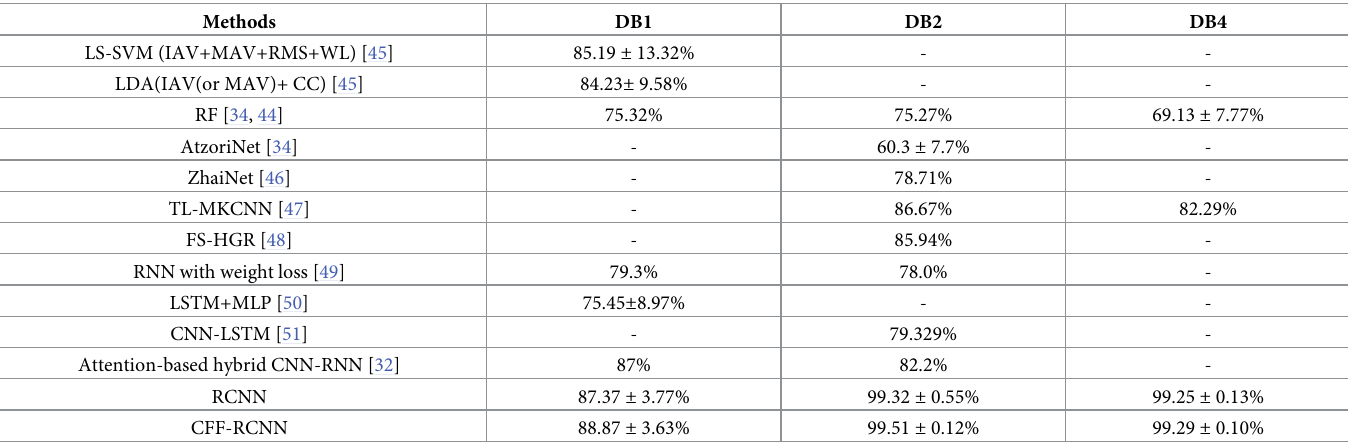
Table 3. Classification accuracy of the compared methods.